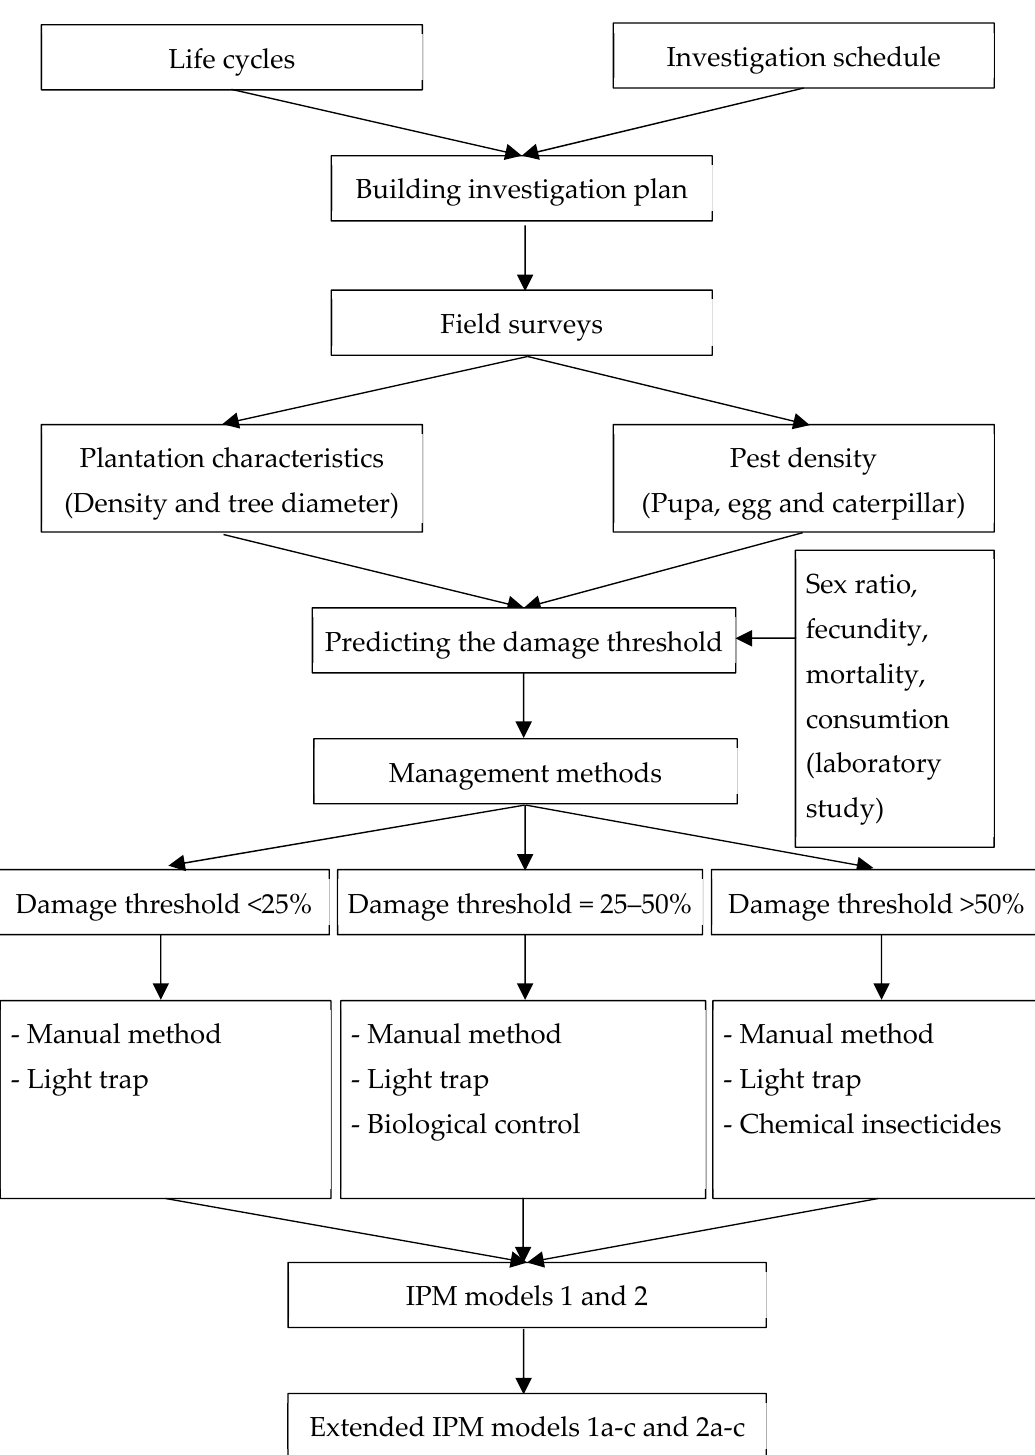
Figure 1. Diagram showing the research steps taken to build integrated pest management models for Dasychira axutha and Dendrolimus punctatus .